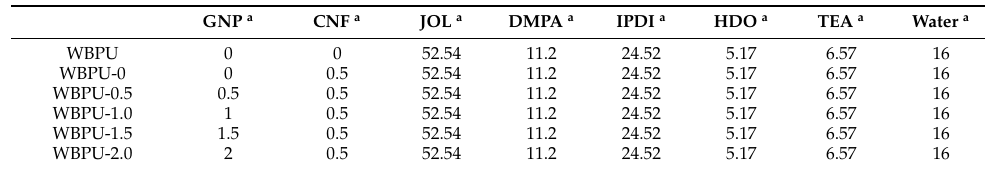
Table 1. Formulation of WBPU synthesis.